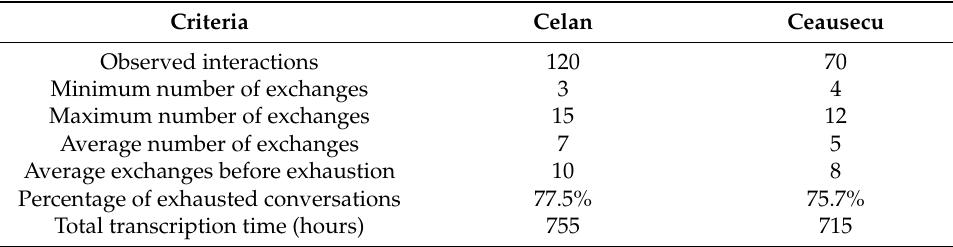
Table 2. Number of interactions and transcriptions per system. Criteria Celan Ceausecu Observed interactions